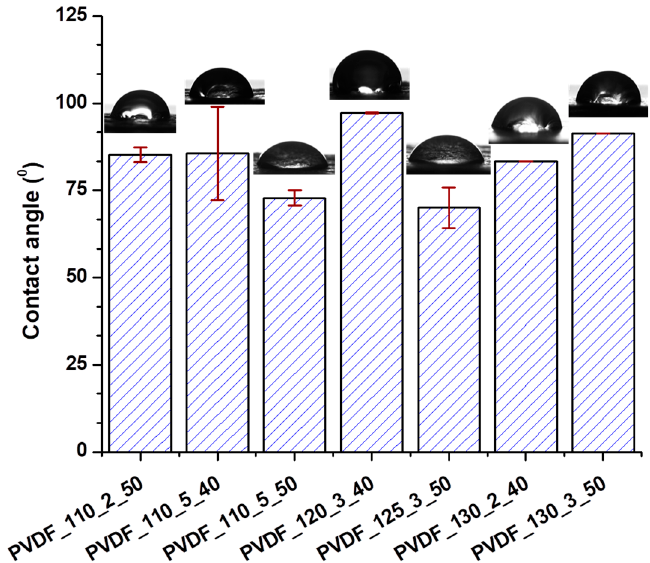
Figure 10. The contact angle of various membranes.